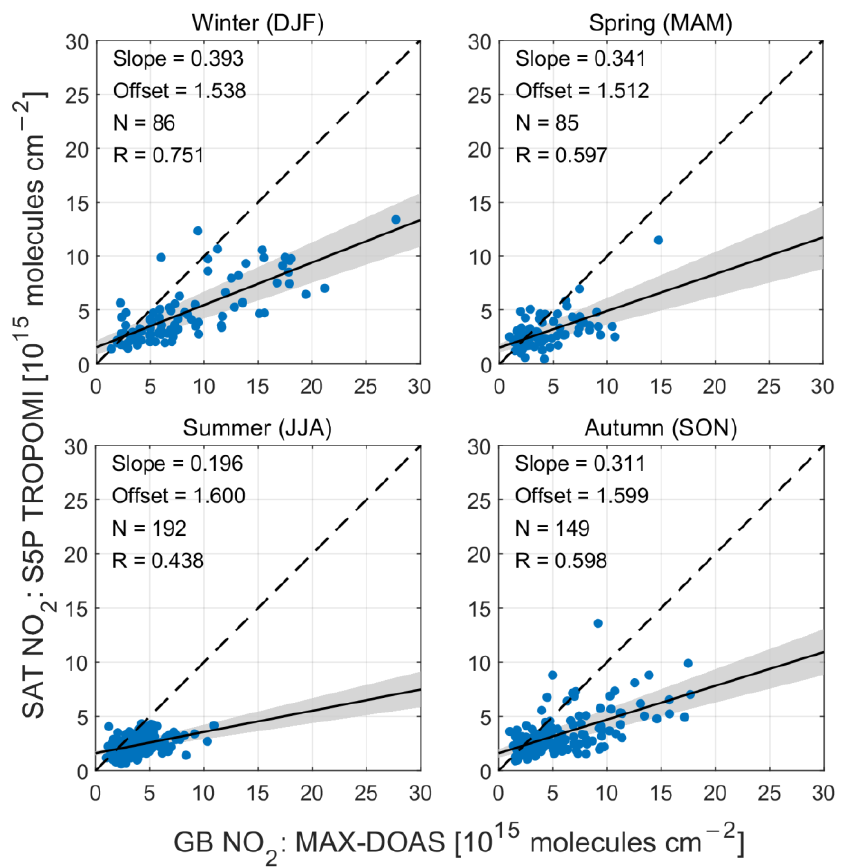
Figure 9. Scatter plots of the daily collocated tropospheric NO 2 VCDs that are reported by the MAX-DOAS and S5P/TROPOMI for all seasons. The gray shaded areas represent the 95% confidence interval of the linear regression fit (solid black line).